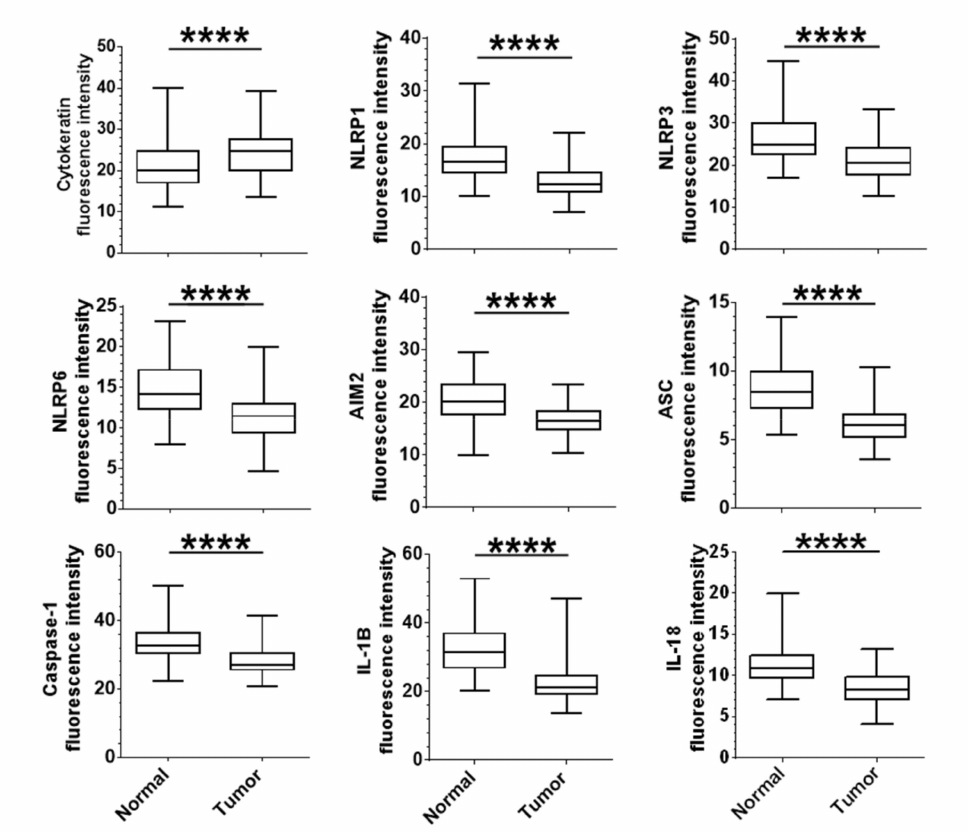
Figure 1. Epithelial protein expression of inflammasome components are downregulated in colorectal cancer patients: Protein expression of cytokeratin, inflammasome components and cytokines in colorectal epithelial normal and tumor cells. Expression levels of each marker were assessed as the mean of all median fluorescence intensity in each cell contained in the cytokeratin mask for each sample of normal and tumor tissues. The mean intensity value of the 3 tumor spots was compared to the mean intensity value of the 2 normal matched samples for each patient. Paired t-test (parametric) or Wilcoxon matched-pairs (non-parametric) were used to evaluate the significance of the di ff erence between normal and tumor tissue. **** p <